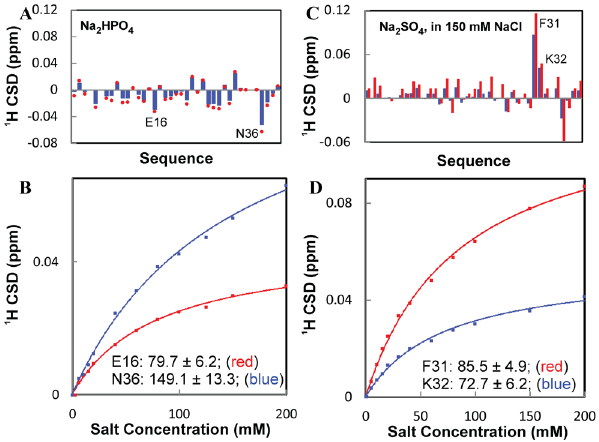
Figure 22. Effects of Na HPO and NaCl in masking the specific 2 4 anion-binding. ( A ) Residue-specific chemical shift differences of amide protons ( 1 H) of the WW4 domain upon addition of Na HPO 2 4 at 150 mM (blue bars) and 200 mM (red circles). ( B ) Residue- specific apparent dissociation constants (Kd) for Glu16 and Lys32. Experimental (dots) and fitted (lines) values are shown for the 1 H chemical shift changes induced by gradual addition of Na HPO . 2 4 ( C ) Residue-specific chemical shift differences of amide protons ( 1 H) upon addition of Na SO at 200 mM to the WW4 sample in unsalted SO under 2 4 2 4 water at pH 6.4 (red bars) and in unsalted water with the pre-existence of 150 mM NaCl at pH 6.4 (blue bars). ( D ) Residue-specific apparent dissociation constants (Kd) for Phe31 and Lys32. Experimental (dots) and fitted (lines) values are shown for the 1 H chemical shift changes induced by gradual addition of Na SO 2 4